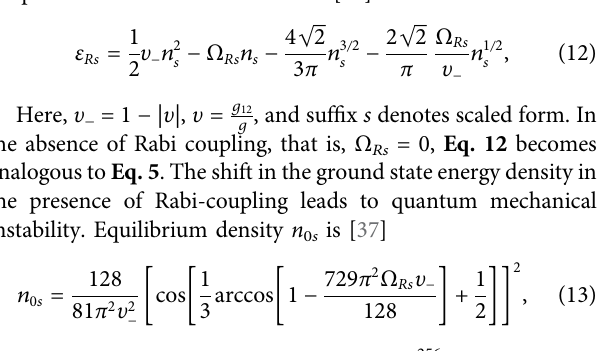
as plotted in 729 π 2